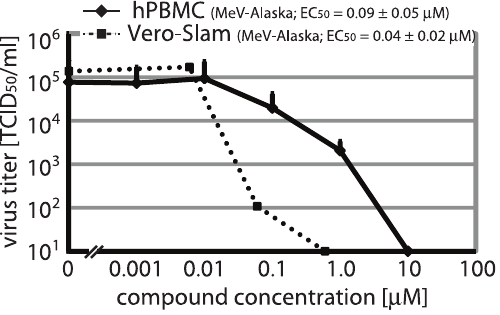
Figure 2. The cellular target range of JMN3-003 extends to primary human cells. Dose-response curves for MeV-Alaska grown in the presence of JMN3-003 on human PBMCs originating from a mixed pool of healthy donors. Vero-Slam cell-based inhibition curves are shown for comparison. Values reflect averages of three replicates. EC 50 concentrations 6 SD are derived from four-parameter non-linear regression modeling.